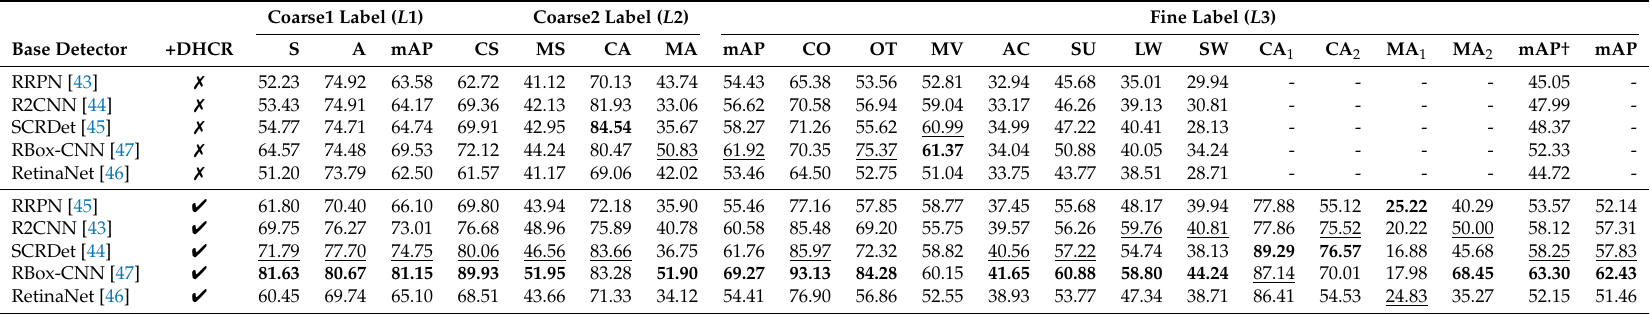
Table 2. Detection results on WorldView-3 test set. Numbers with bold indicate the highest score, and numbers in underline indicate the second highest score on each category. Without applying DHCR, we are limited to evaluation for incomplete -categories due to a single classifier structure of existing detection models, where the single classifier is trained for complete -categories. Notations: S = Ship, A = Aircraft, CS = Civilian Ship, MA = Military Ship, CA = Civilian Aircraft, MA = Military Aircraft, CO = COntainer, OT = Oil Tanker, MV = Maritime Vessels, AC = Aircraft Carrier, SU = SUbmarine, LW = Large Warship, SW = Small Warship, For each dataset, we report the performance for certain aircraft at level3 (L3) in the order of the most frequent appearance among the various aircraft: CA 1 = A-340, CA 2 = B-757, MA 1 = AN-12, and MA 2 = C-130 in WorldView-3, and CA 1 = A-380, CA 2 = B-747, MA 1 = C-17, and MA 2 = C-130 in SkySat dataset. mAP† averages detection performance excluding CA 1 , CA 2 , MA 1 , and MA 2 at level 3.